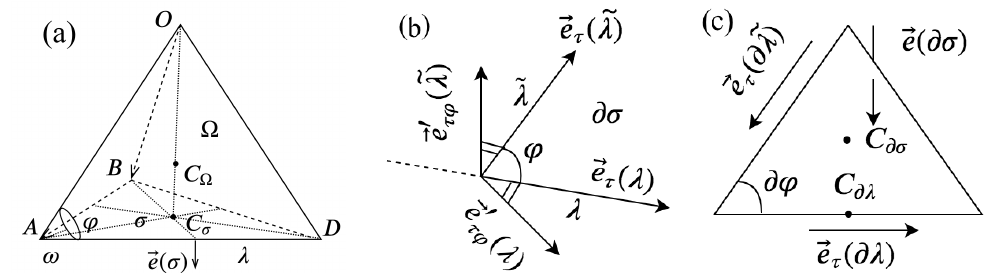
−−−−→ C ∂σ C ∂λ , s σ ( λ ) = − 1, s ∂σ = − 1. Beyond the face ∂σ ,